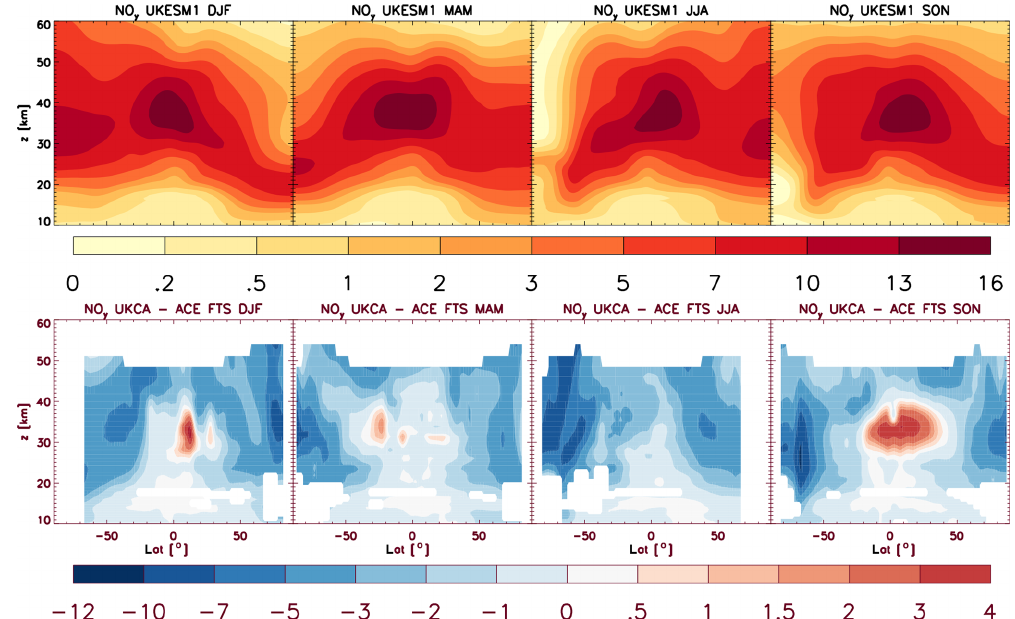
Figure 21. Same as Fig. 22 but for odd nitrogen (NO y ), defined here as NO y = NO + NO 2 + HNO 3 (ppb). For ACE-FTS, NO and NO 2 fields are the average of sunrise and sunset measurements. The model values are averaged over all local